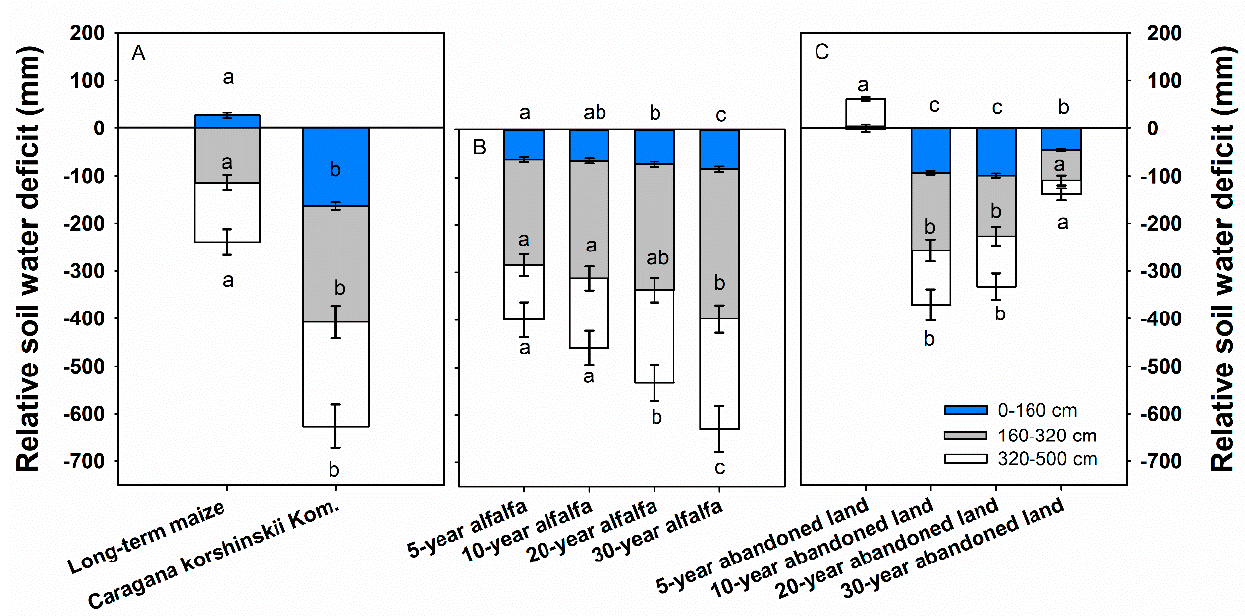
Figure 5. Effects of land use on the relative quantity of soil water deficit in different soil layers under long-term maize and Caragana korshinskii Kom (A), alfalfa (B) and abandoned land (C). Different lowercase letters represent significant differences at p ≤ 0.05 between treatments.